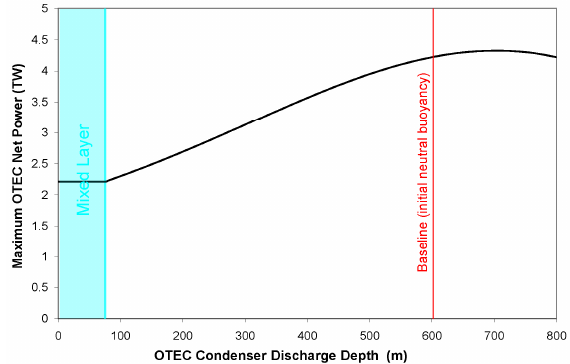
Figure 6. Maximum OTEC net power as a function of condenser-effluent discharge depth, with the evaporator effluent discharge within the mixed layer; the red line indicates the so-called baseline protocol (initial neutral buoyancy).